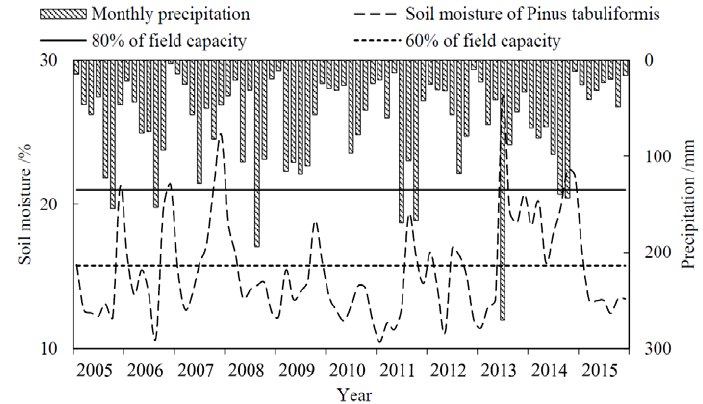
Figure 3. Monthly average soil moisture in Pinus tabuliformis Plantation in 2005–2015 growing seasons.